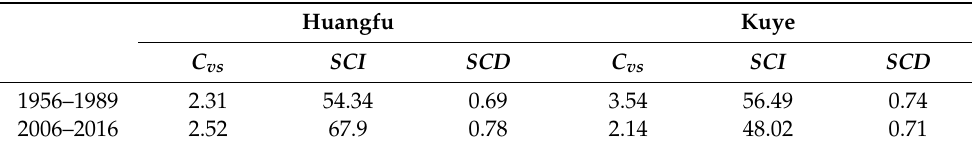
Table 3. Average values of sediment indexes in two periods.